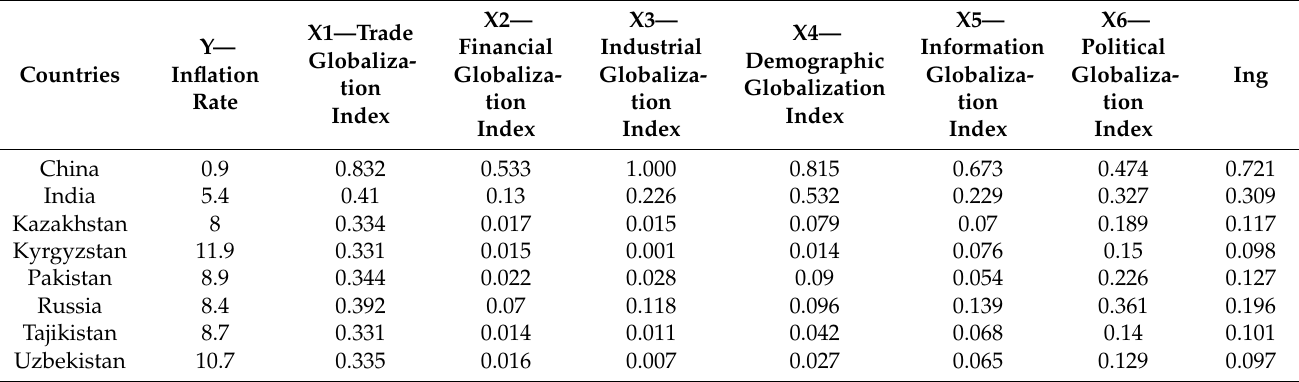
Table 5. Calculation of the composite integration index for the SCO countries.